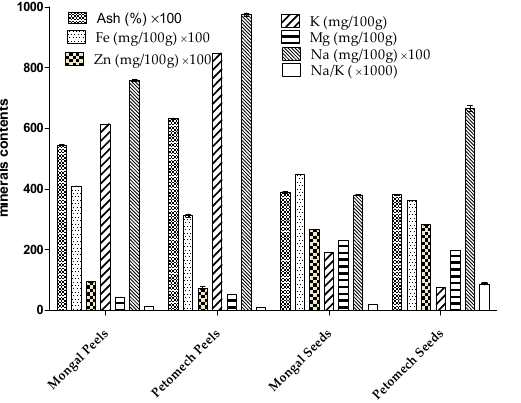
Figure 3. Ash and mineral contents of seeds and peels of F1 Mongal and Petomech.